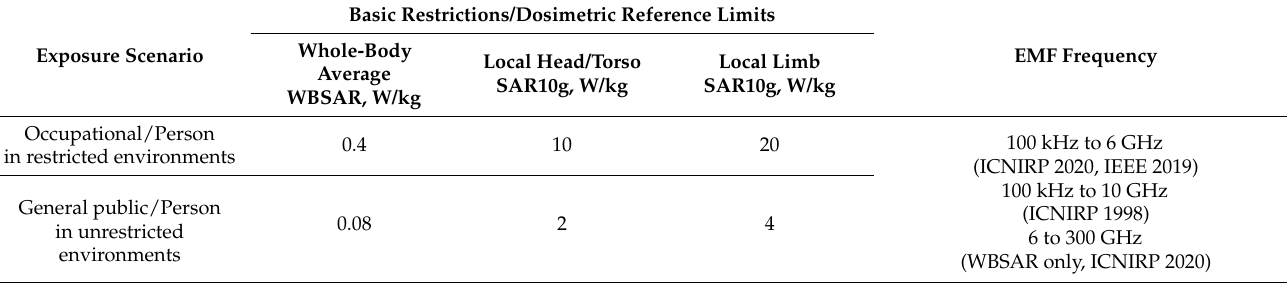
Table 1. SAR limits applicable for evaluating exposure to EMF at 865–868 MHz and 915–921 MHz frequencies used by UHF RFID